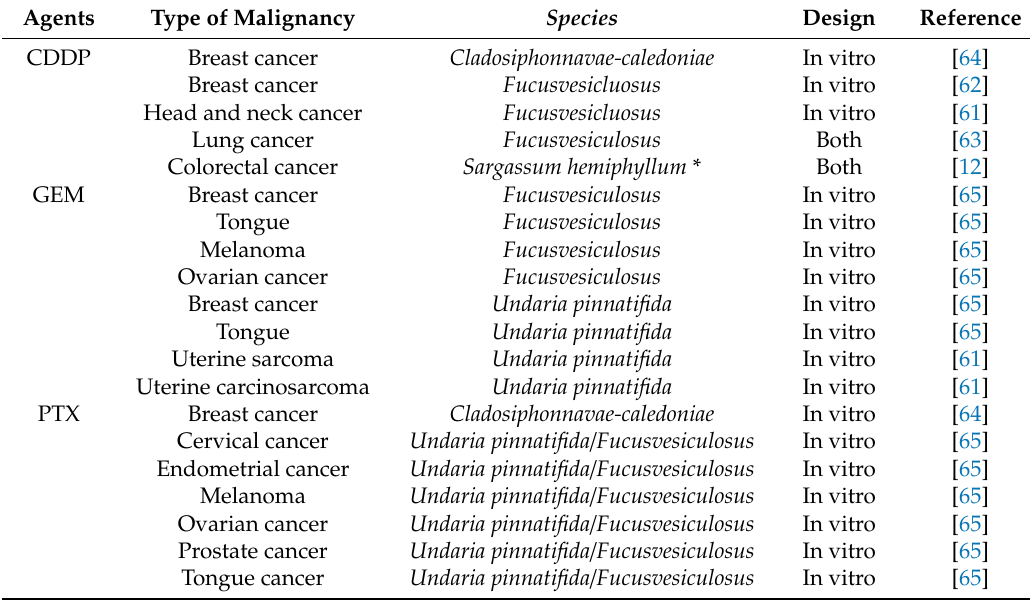
Table 4. Increased anti-cancer e ff ects of fucoidan combined with chemotherapeutic agents. Agents Type of Malignancy Species Design Reference CDDP Breast cancer Cladosiphonnavae-caledoniae In vitro [64] Breast cancer Fucusvesicluosus In vitro [62] Head and neck cancer Fucusvesicluosus In vitro [61] Lung cancer Fucusvesiculosus Both Colorectal cancer Sargassum hemiphyllum * Both GEM Breast cancer Fucusvesiculosus In vitro Tongue Fucusvesiculosus In vitro Melanoma Fucusvesiculosus In vitro Ovarian cancer Fucusvesiculosus In vitro Breast cancer Undaria pinnatifida In vitro Tongue Undaria pinnatifida In vitro Uterine sarcoma Undaria pinnatifida Uterine carcinosarcoma Undaria pinnatifida In vitro PTX Breast cancer Cladosiphonnavae-caledoniae In vitro Cervical cancer Undaria pinnatifida / Fucusvesiculosus Endometrial cancer Undaria pinnatifida / Fucusvesiculosus Melanoma Undaria pinnatifida / Fucusvesiculosus Ovarian cancer Undaria pinnatifida / Fucusvesiculosus Prostate cancer Undaria pinnatifida / Fucusvesiculosus Tongue cancer Undaria pinnatifida /